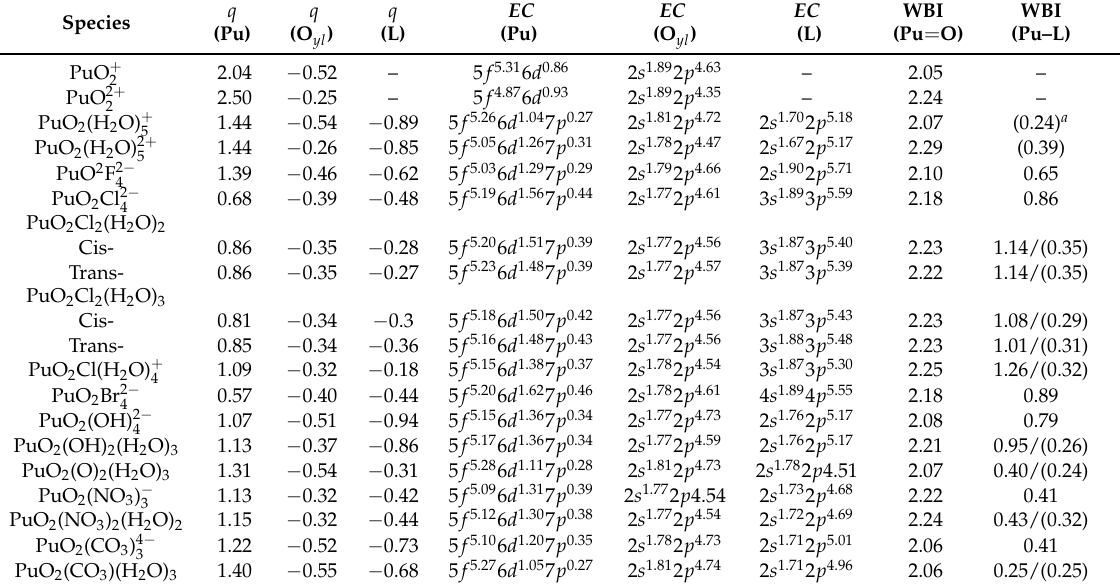
Table 3. The Natural population analyses (NPA) charge (q) and electronic configurations (EC) of Plutonium, Oxygen in plutonyl (O yl ) and coordinating atoms in ligands (L) of studied Plutonyl (VI) complexes, the Wiberg bond index (WBI) of Pu=O and Pu–L chemical bonds.